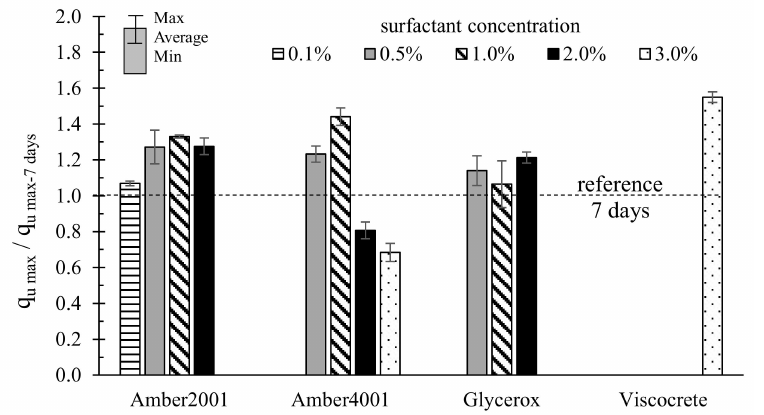
Figure 4. Strength improvement factor (for samples with 7 curing days) for the stabilized soil with only surfactant